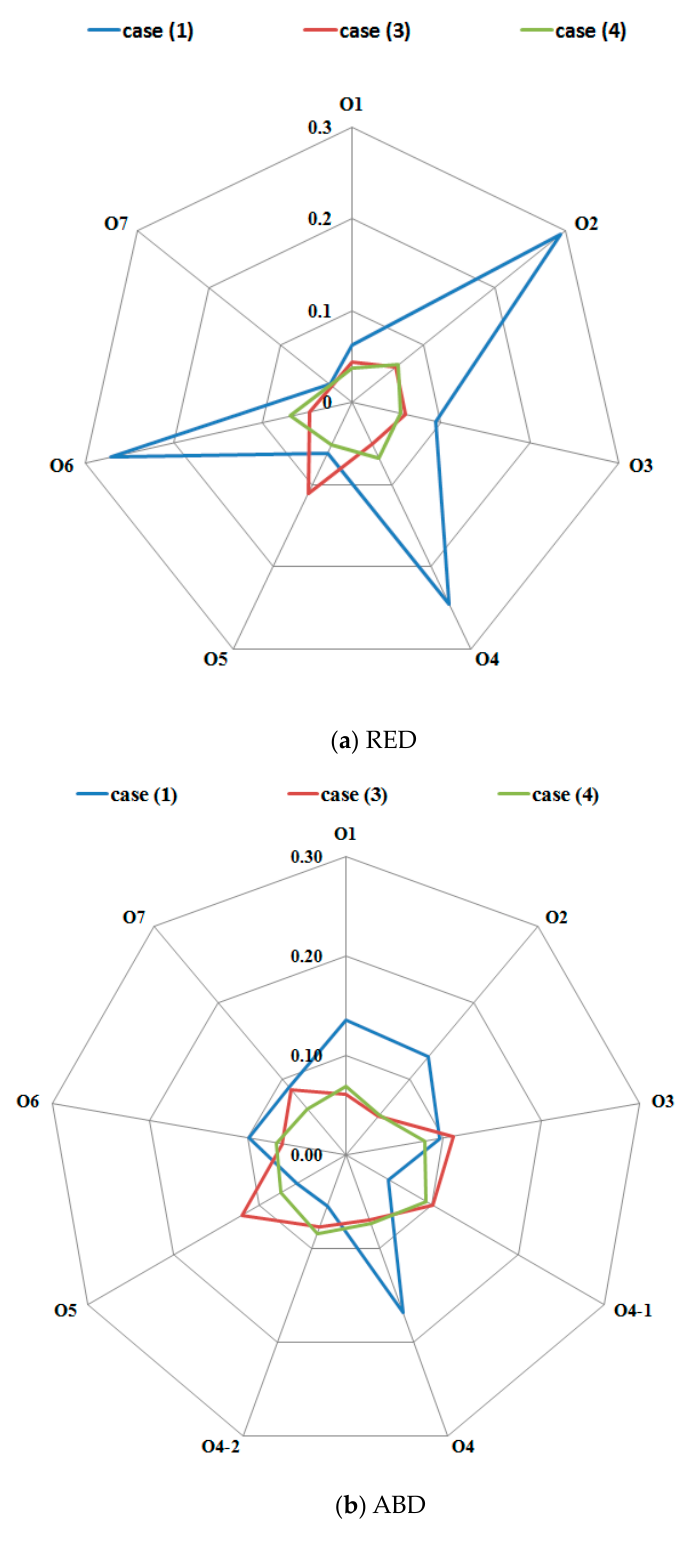
Figure 6. RED and ABD values of different regions in Cases 1, 3, and 4.